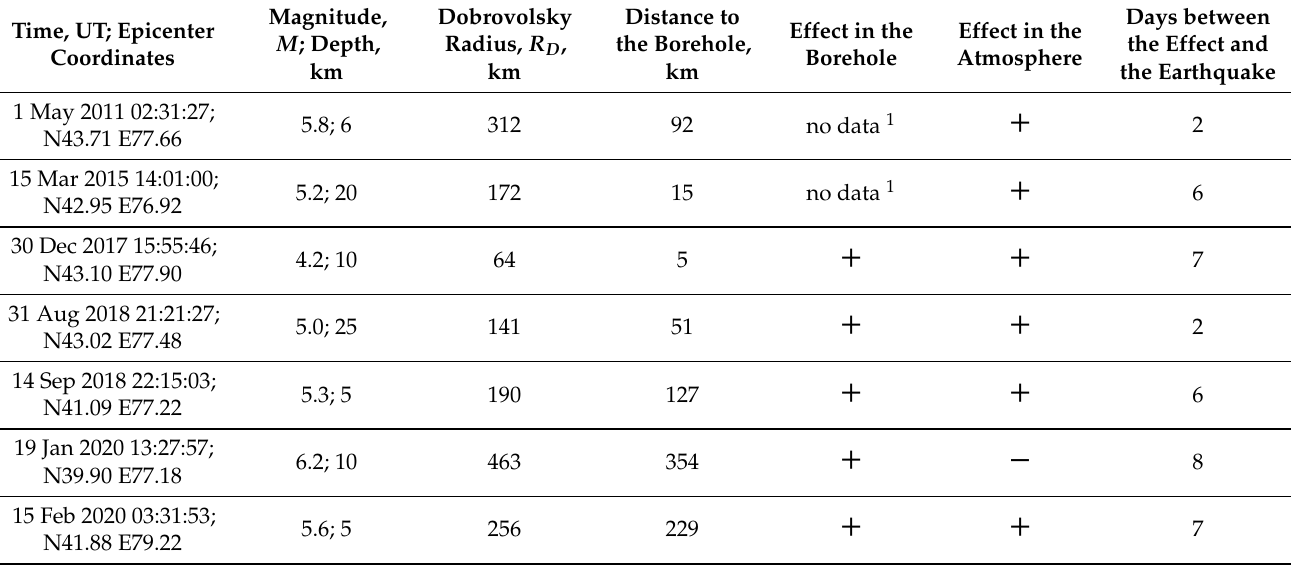
Table 1. The list of the earthquakes with anomalous effects detected during the period of their preparation in the time series of gamma ray